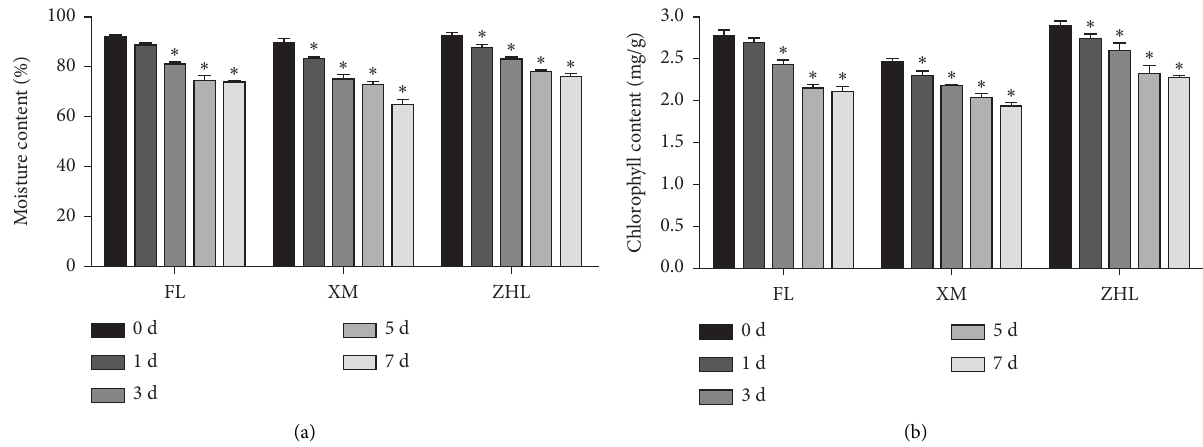
Figure 1: The changes of moisture content (a) and chlorophyll content (b) of the annual branches of the three varieties of pitaya with cold treatment. “ ∗ ” indicates the changes of moisture content and chlorophyll content with a significant difference at p < 0 . 05 compared with the control group.